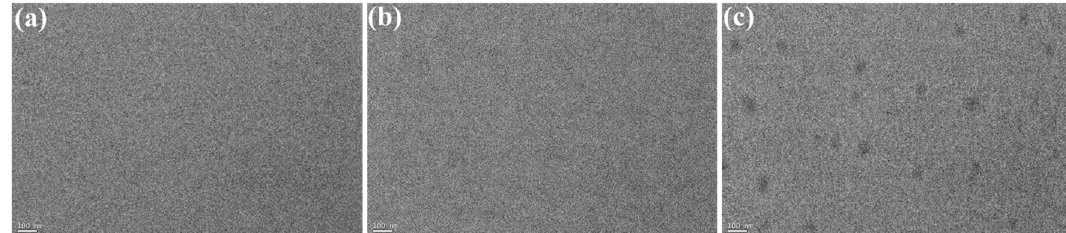
Figure 10. Transmission electron microscopy (TEM) bright field images of photoactive layers for PIDTT-DTBT / PC 61 BM (1:2, 3%DIO, ( a )), PIDTT-TBT / PC 71 BM (1:2, 3%DIO, ( b )) and PIDTT-TFBT / PC 61 BM (1:1.5, 3%DIO, ( c )). The scale bar of TEM images is 100 nm.